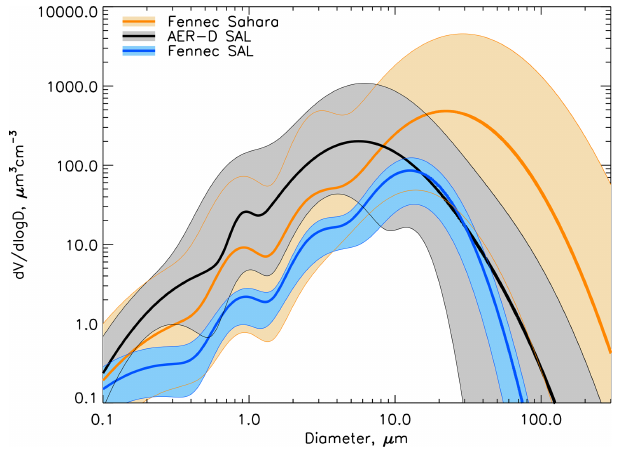
Figure 2. Campaign ambient mean log-fit size distributions for Fennec-Sahara (orange), AER-D SAL (black), and Fennec-SAL (blue). Bold lines indicate field campaign mean PSDs, and shading indicates min : max range for SAL data and 10th per- centile : maximum range for